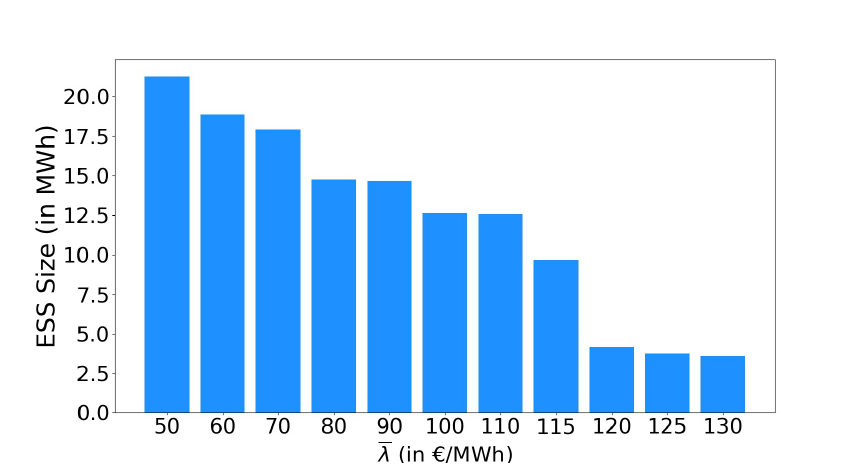
Figure 6. Required size of ESS to constrain prices under different contractual